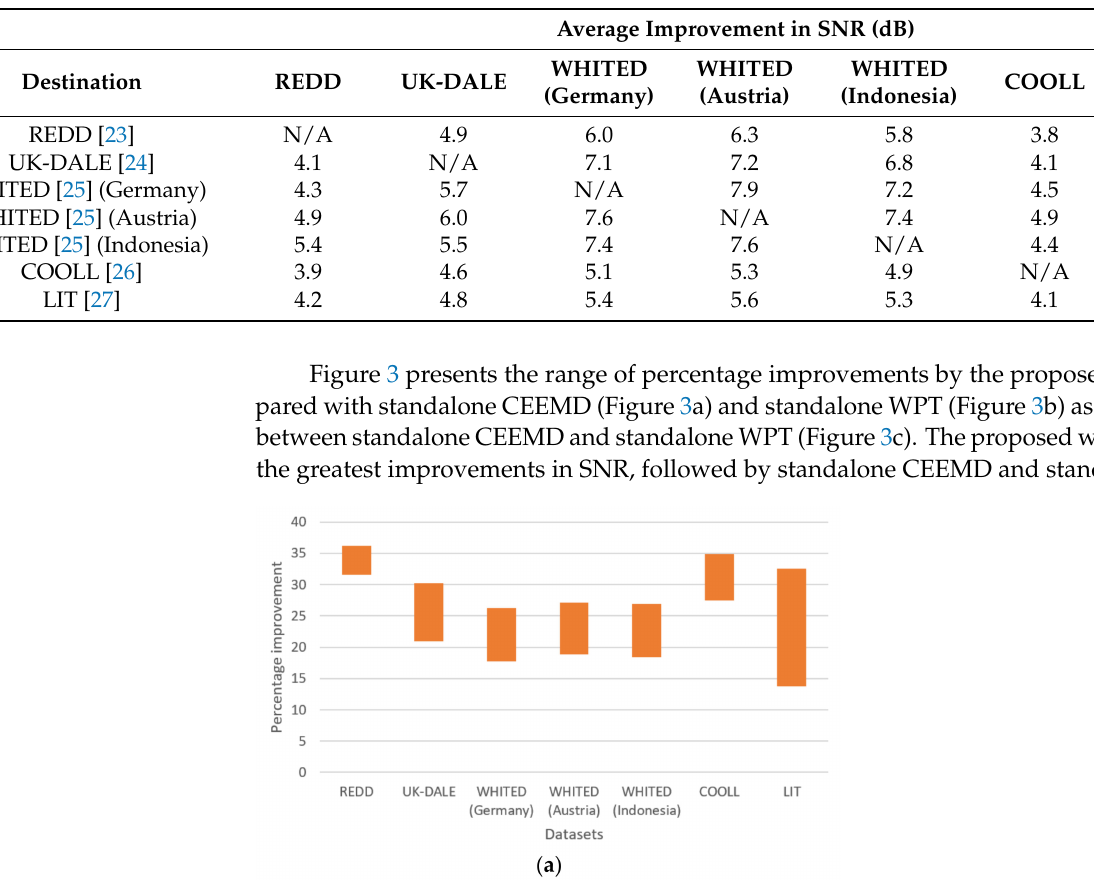
Table 5. Average improvement in SNR with standalone